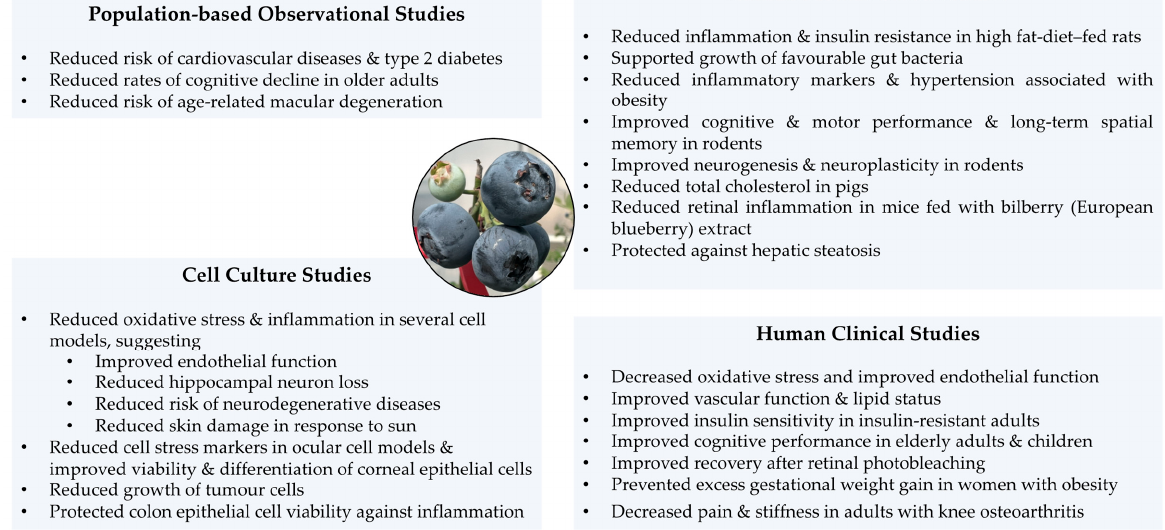
Figure 2. Health bene fi ts of blueberry consumption. The most signi fi cant health-related bene fi ts of blueberry are based on the antioxidant and anti-in fl ammatory actions of the phytochemicals, mainly anthocyanin, contained in the fruit [6–8,30,59–63].